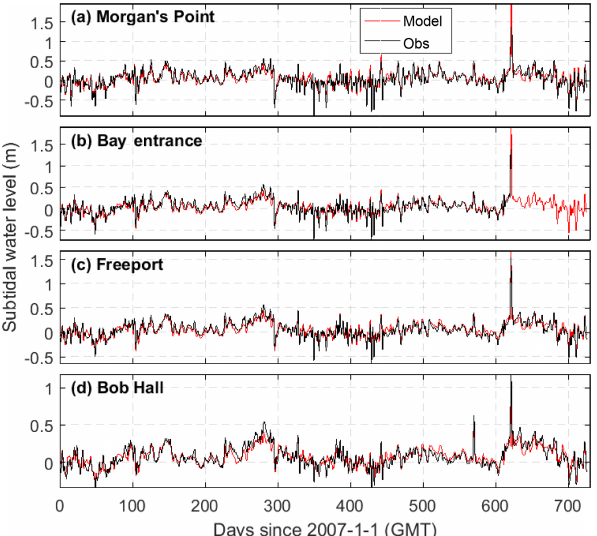
Figure 3. Subtidal surface elevation comparison between the model (red line) and observations (black line) at NOAA tidal gauge sta- tions (see Fig. 2 for their